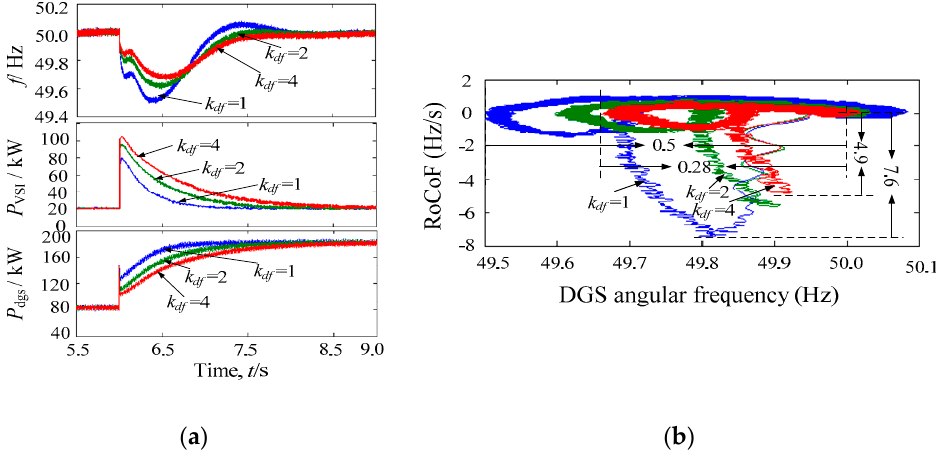
Figure 19. ( a ) Experimental results of the different differential feedforward gains ( D = 0 and J = 0) on an active power transient; ( b ) Angular frequency-acceleration curves of DGS with differential feedforward control loop.